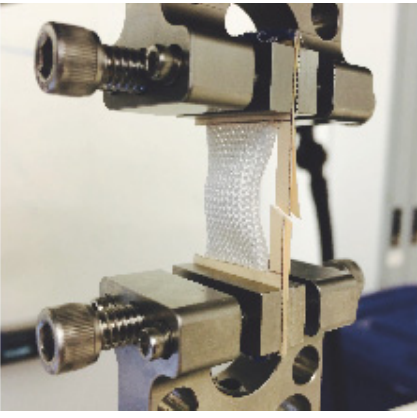
Figure 5. Sample placed in grips of the Bose Electro Force 3200 Series Axial Configuration tensile tester.